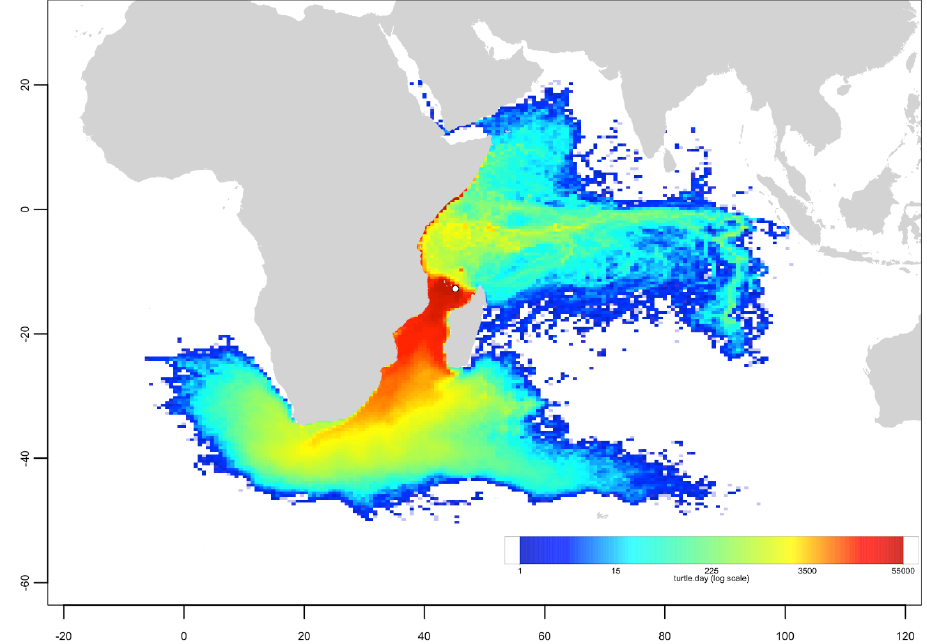
Figure A5. Mayotte dispersal map. One-year long trajectories of 10,000 particles released from a 0.25° × 0.25° areas located about 40 km off the main nesting beaches of Mayotte (with circle) from 2002 to 2006 (for a total of 50,000 particles). The color indicates the density of particles in number of turtles per day (log scale).